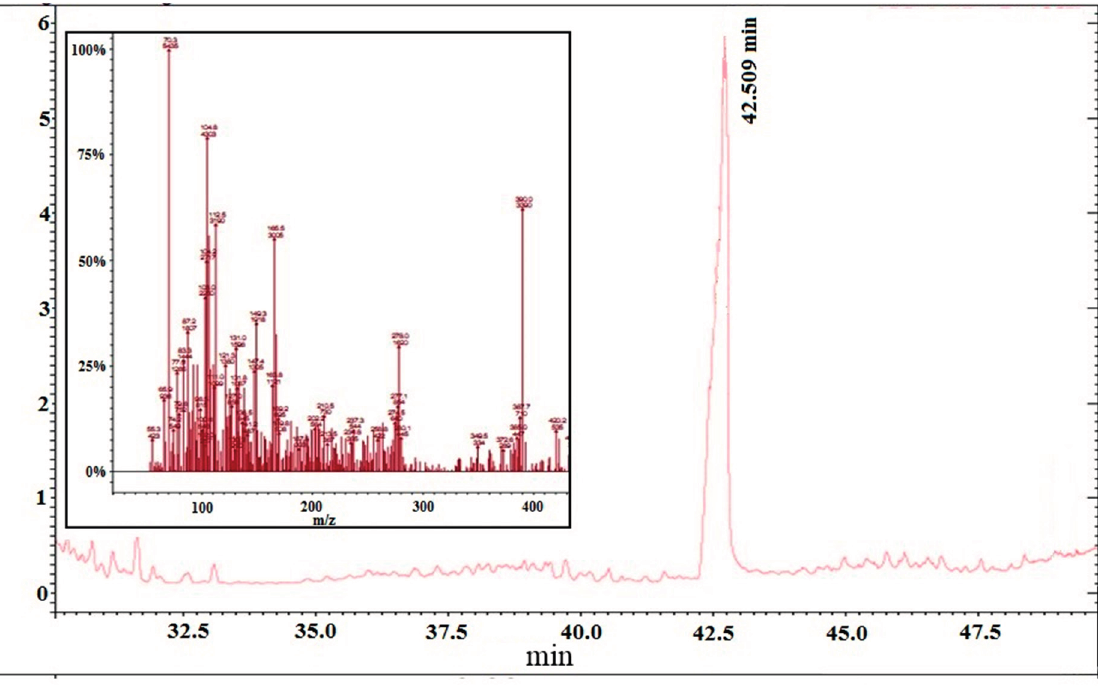
Figure 4. GC-MS spectra of M12a fraction obtained from lipidic extracts of